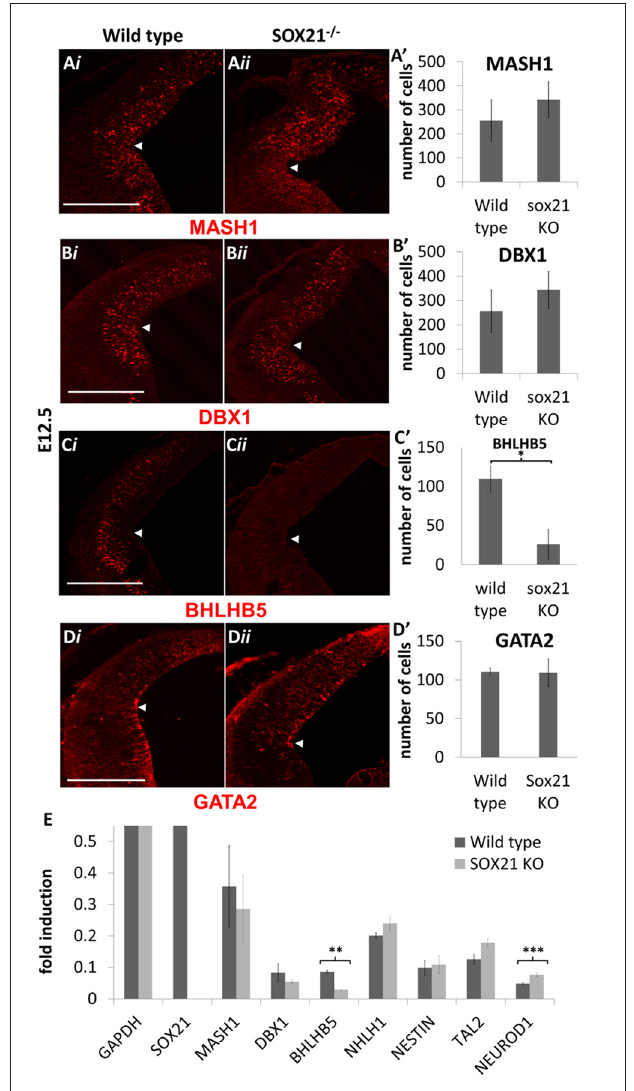
FIGURE 4 | Analysis of lineage-determining factors in SOX21 − / − embryos at E12.5. The immunostaining of the lineage-determining factors MASH1 (A,A (cid:48) ) , GATA2 (B,B (cid:48) ) and DBX1 (C,C (cid:48) ) was similar between knockout ( ii ) and wild type embryos ( i ). A significant reduction in the BHLHB5 staining was observed in the Knockout embryos in comparison to wild type (D,D (cid:48) ) . All nuclei were counted dorsally to the ventrolateral midbrain sulcus (indicated by white arrow). These data were confirmed by RT-Q-PCR analysis of embryos at the same age (E) . Data are represented as mean ± SEM, n = 10 (5 pairs of mice). ∗ n = 10 (5 pairs of mice), P = 0.0116, two-tailed Mann-Whitney test. ∗∗ n = 6 (3 pairs of mice), p = 0.025, DF = 1, Kruskal Wallis test. ∗∗∗ n = 6 (3 pairs of mice), p = 0.0253, DF = 1, Kruskal Wallis test. Scale bar, 150 µ